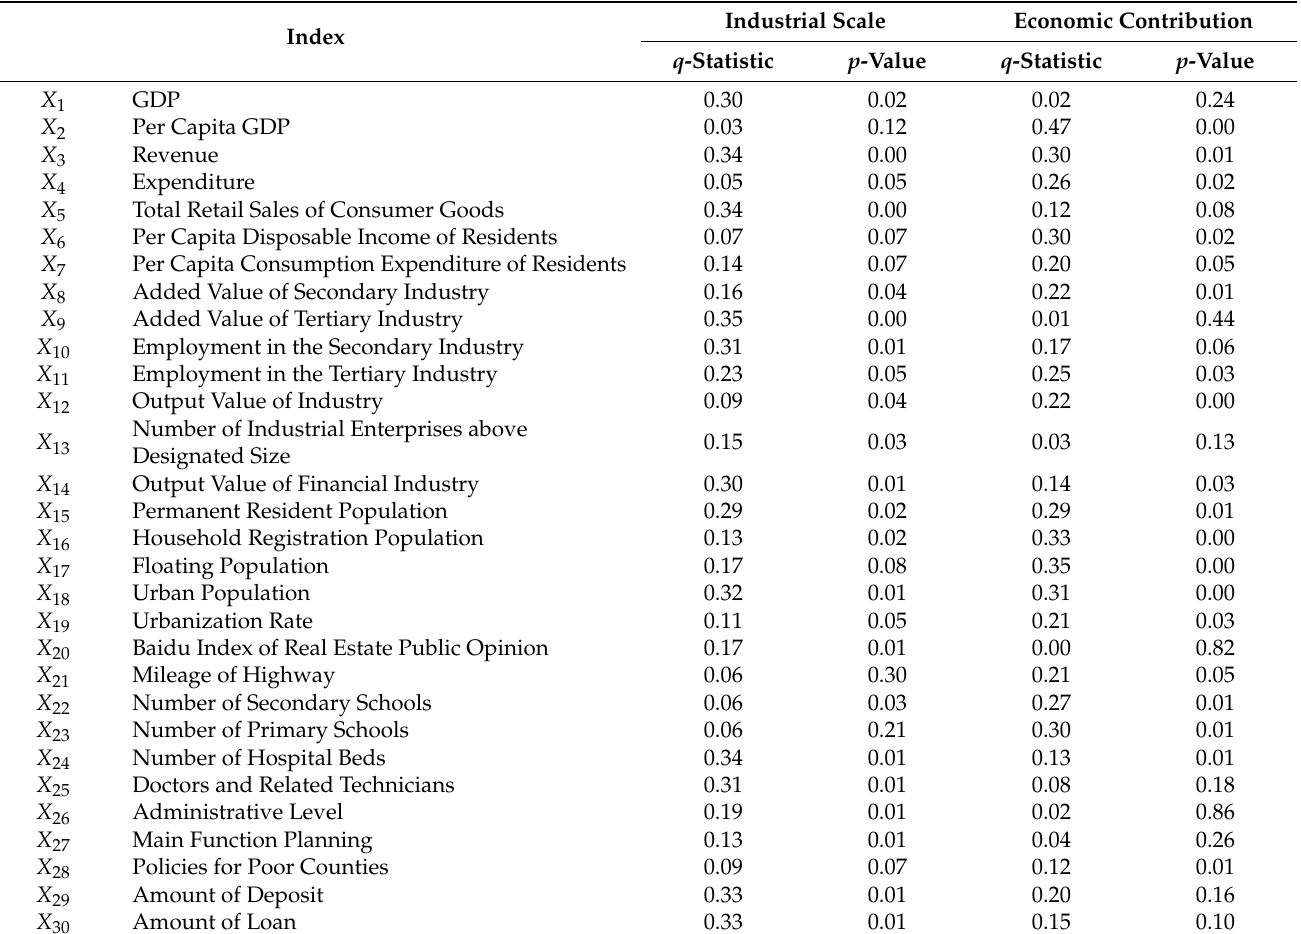
Table 3. Analysis of factor